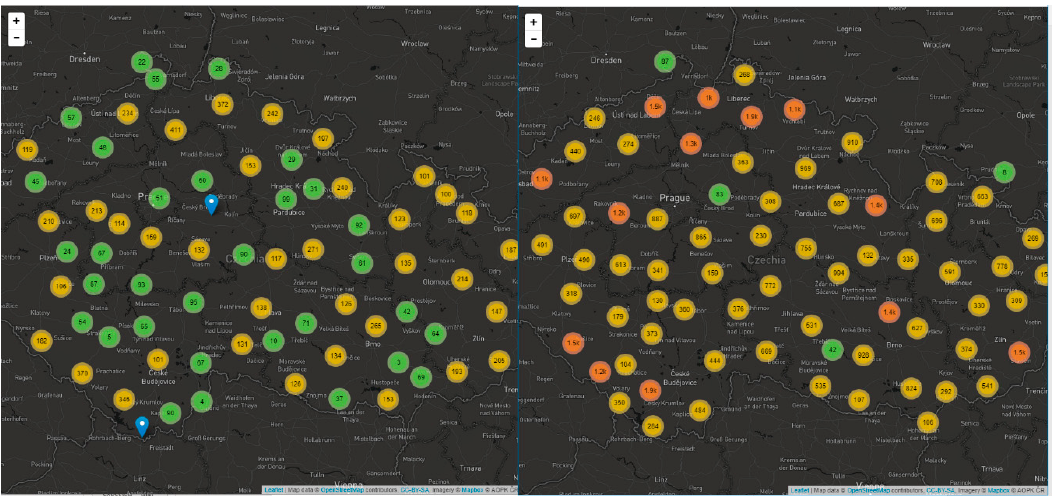
Table 4. Results of testing Supercluster library (values in milliseconds).